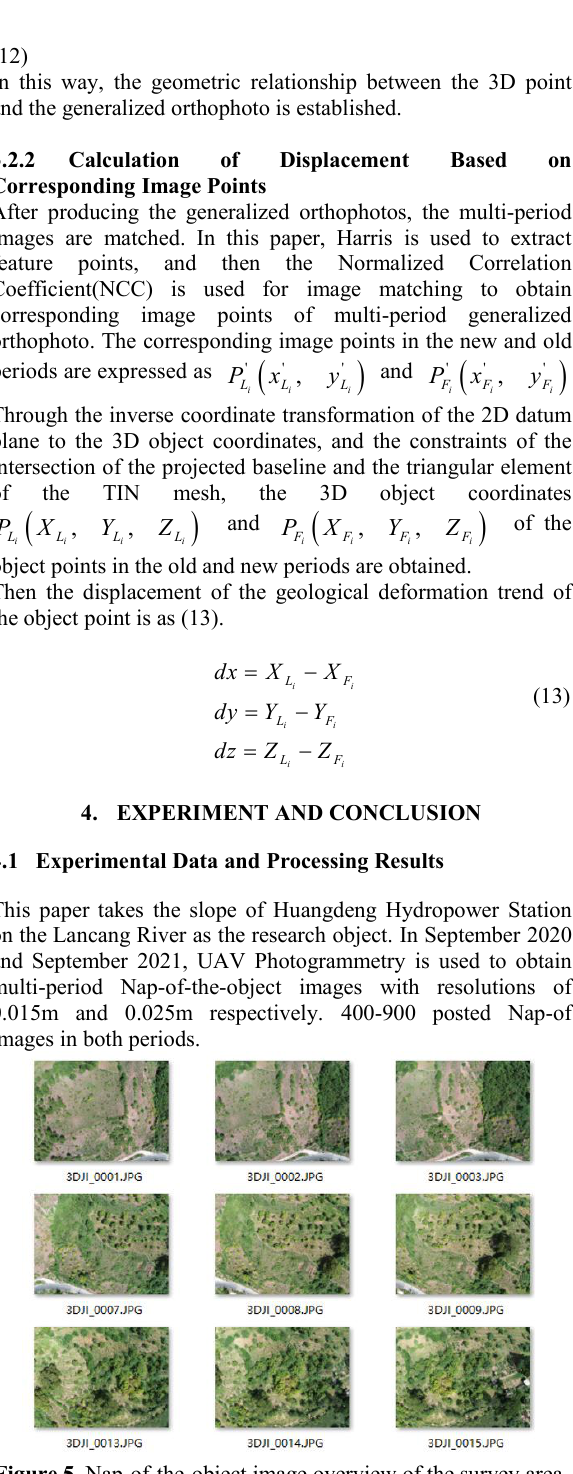
Figure 5 . Nap-of-the-object image overview of the survey area.